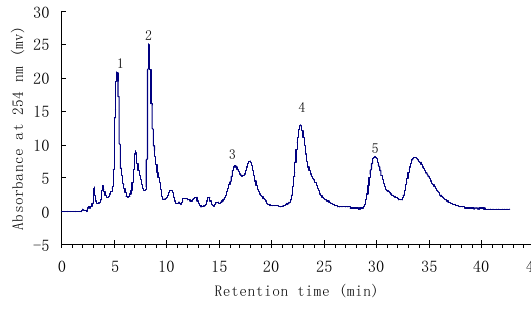
Figure 1. HPLC chromatogram of the ethyl acetate crude extract from H. halodendron